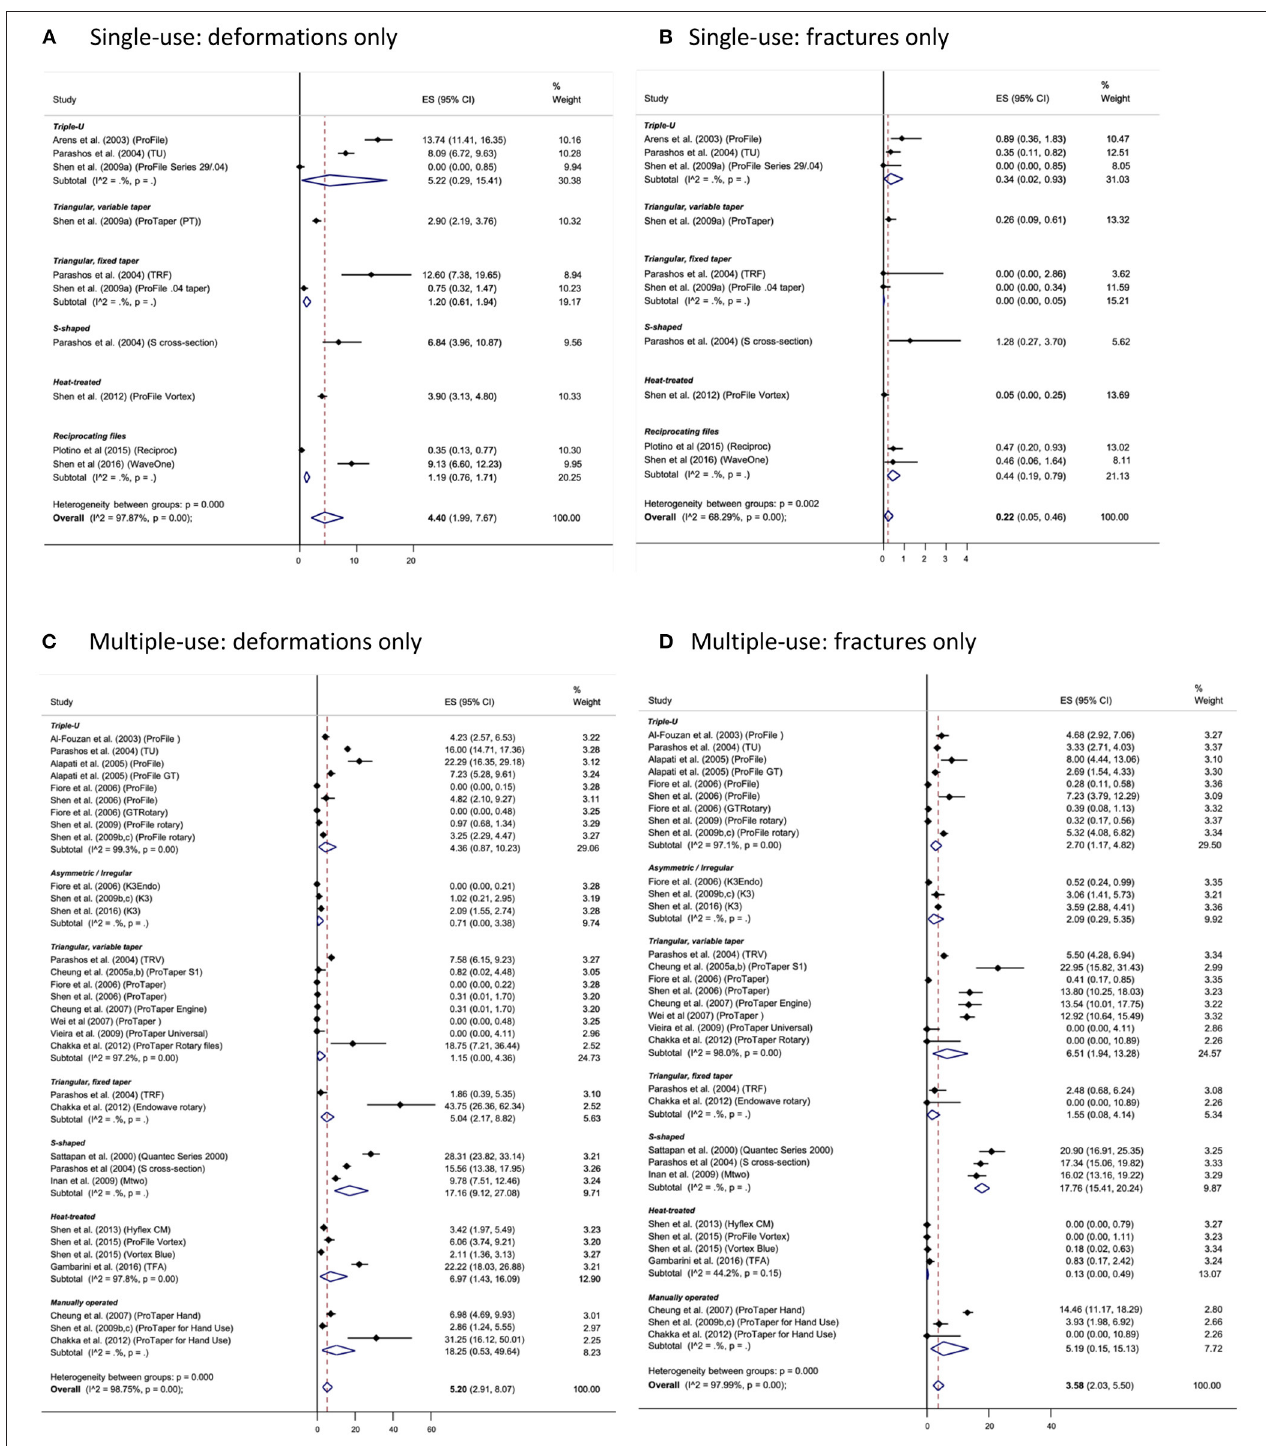
FIGURE 3 | Forest plots of computed defect rate for NiTi instruments that were reported as being single use (A,B) vs. multiple uses (C,D) . [Note different scale for the x-axis in different charts].